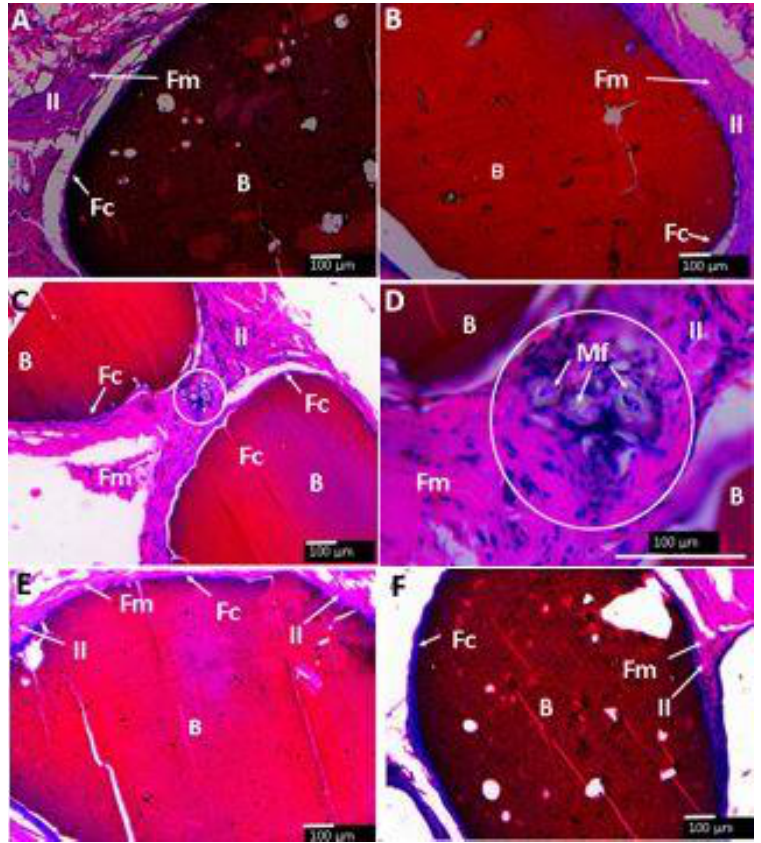
Figure 13. Beads implanted in subdermal tissue. ( A ) CS-GO-TiO 2 -GLA. ( B ) CS-TiO 2 - GLA. ( C ), ( D ) CS-GLA. ( E ) CS-GO-GLA. ( F ) CS-GO-TiO 2 -GLA. II: Inflammatory infiltrate. Fm. Fibrous membrane. Fc: Fibrous capsule. B: Bead. Mf: Macrophages. 10× images. Masson′s trichrome stain (MT) technique.